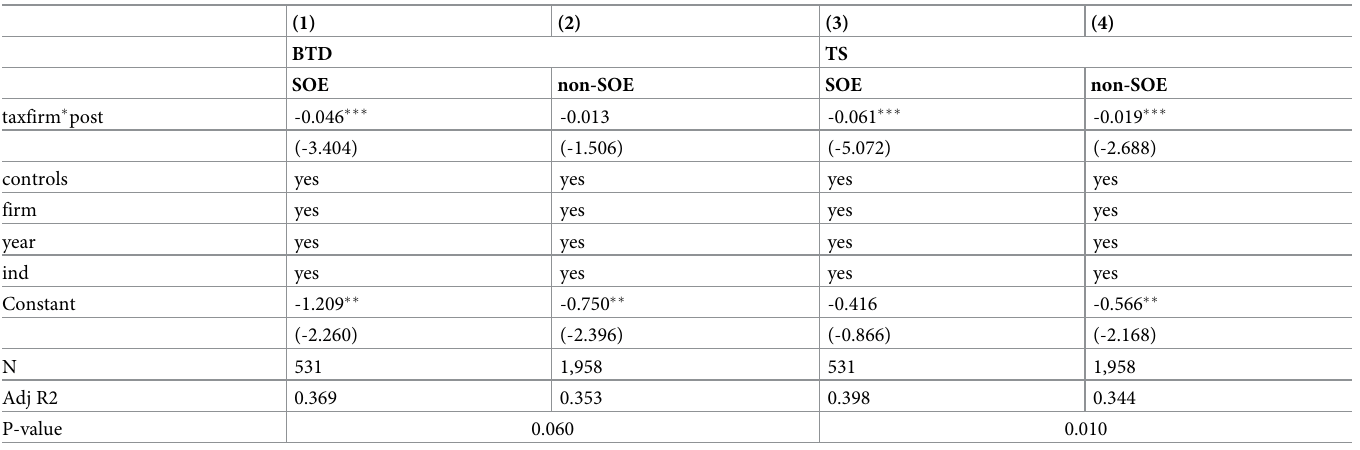
Table 13. Effect of tax-related comment letters on firms’ tax avoidance among different